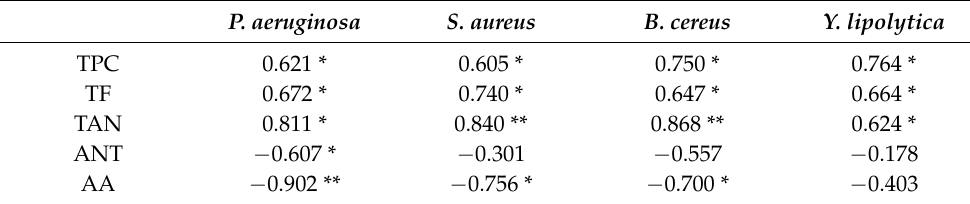
Table 5. Pearson’s correlation coefficient ( r ) and significance between the bioactive potential of each extract and the inhibition halos caused by pomegranate extracts against the tested microorganisms. P. aeruginosa S. aureus B. cereus Y. lipolytica TPC 0.621 * 0.605 * 0.750 * 0.764 * TF 0.672 * 0.740 * 0.647 * 0.664 * TAN 0.811 * 0.840 ** 0.868 ** 0.624 *